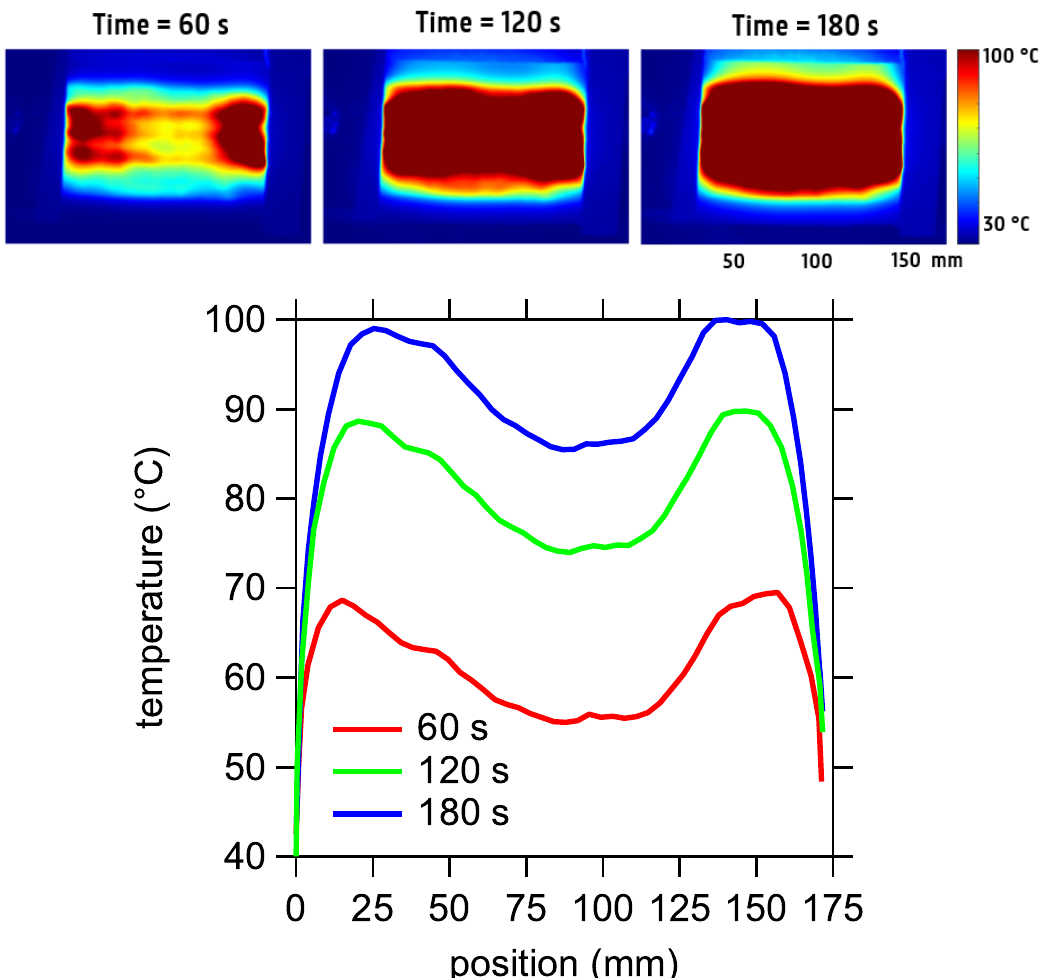
Figure 8. Infrared inspection ( top ) and the temperature profile at the surface of a 300 nm fully coated prepreg ply ( botto m). The applied voltage was 40 V, the resistance of the line heating pattern 8.4 Ω and the current in the circuit was 4.6 A. The total amount of dissipated power by the heater is calculated as approximately 180 W. Averaged over the total surface area of the sample, the average dissipated power density by the heating element yields 5.9 W/cm 2